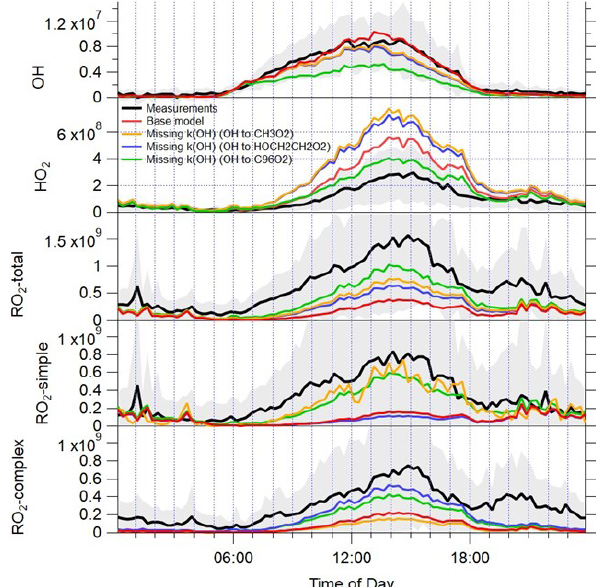
Figure 10. Average diel profiles for the observed OH, HO 2 , total RO 2 and partially speciated RO 2 (black lines) at 15min intervals over 24h. The error bars represent the 1 σ standard deviation of the measurements. The average OH, HO 2 , total RO 2 and partially spe- ciated RO 2 model profiles when the missing reactivity observed at a given time is accounted for by different OH to RO 2 reactions are overlaid (yellow, blue and green lines); the base model predictions are in red. See text for